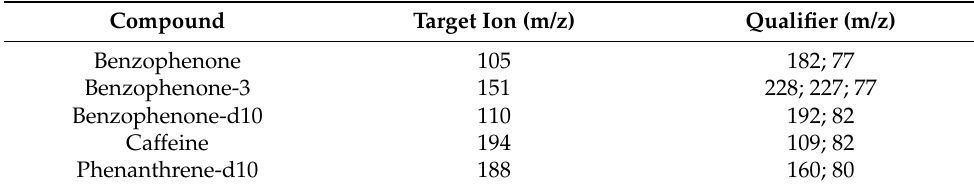
Table 5. Target ions and